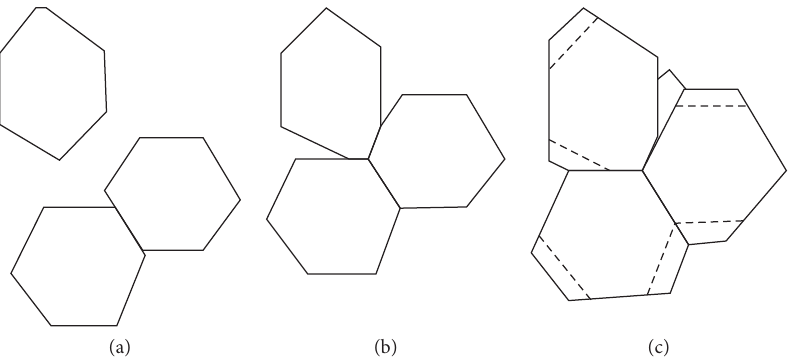
Figure 9: Schematic illustration of TiC collision and sintering within Co alloy melt: (a) a stuck TiC moving at faster speed v2 catching up a single TiC; (b) collision with each other; (c) partial sintering among TiC particles and growth of the whole